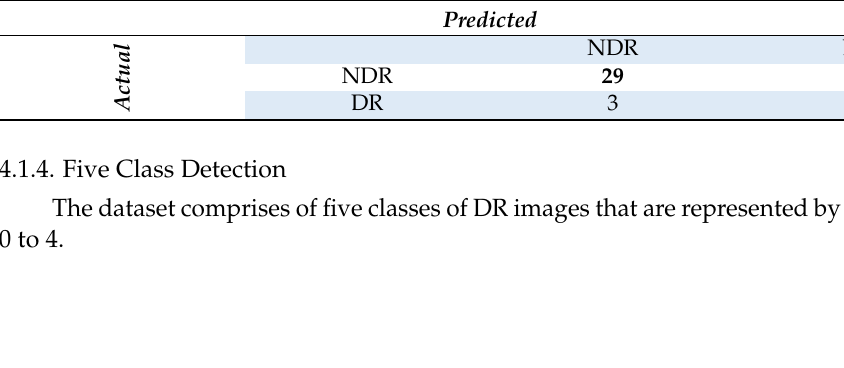
Figure 10. Retinal images for ( a ) Normal ( b ) Mild DR ( c ) Moderate DR ( d ) Severe DR ( e ) Proliferative DR.